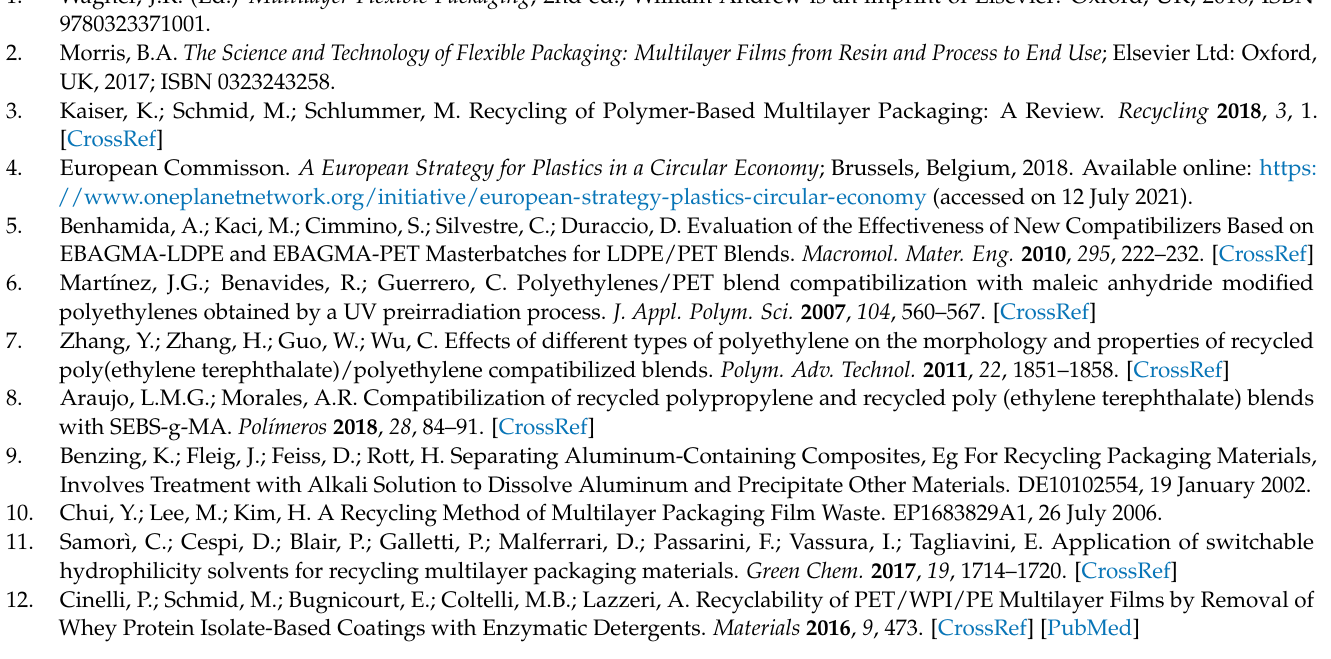
Figure S2: Comparison of the ring deformation band of the maleimide group at 696 cm − 1 from the cured adhesive exposed to 105 ◦ C for 20 min and the cured/uncured adhesive. Figure S3: DSC curve of the initial PE film (green) and recycled PE film (blue). Figure S4: DSC curve of initial PET film (blue) and regranulated PET (green). Figure S5: DSC curves of the recycled PET. Shown are the first heating run in black, the cooling curve in red, and the second heating run in blue. Table S1: Data from DSC evaluation of initial PE film and recycled PE film. Table S2: Data from DSC evaluation of initial PET film and reganulated